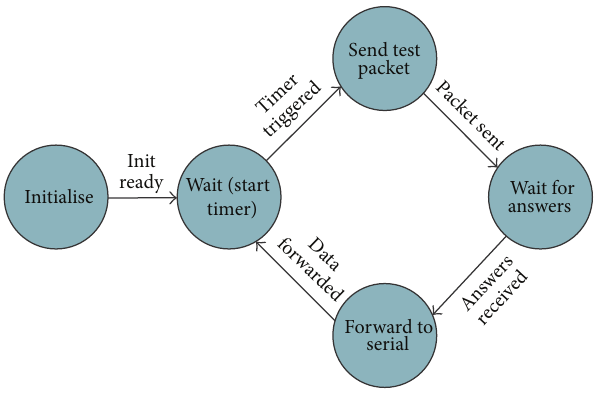
Figure 5: Workflow diagram of the gateway application.